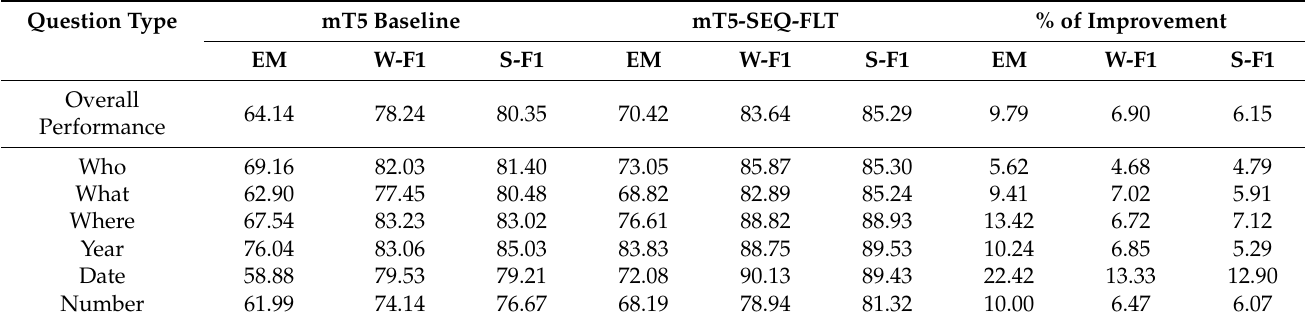
Table 9. Model performance evaluated on the Thai Wiki QA dataset classified by question types.